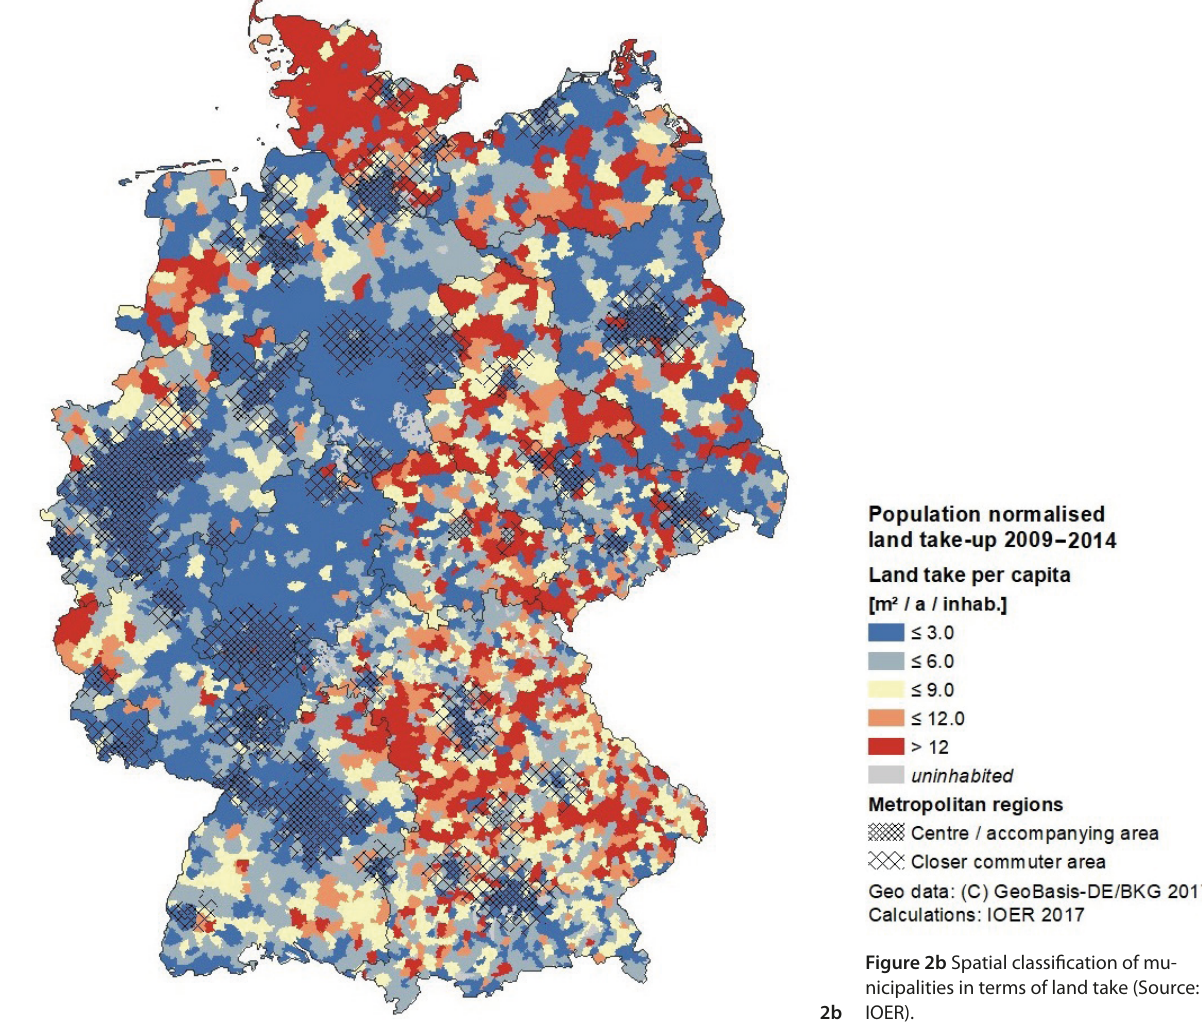
Figure 2b Spatial classification of mu- nicipalities in terms of land take (Source: